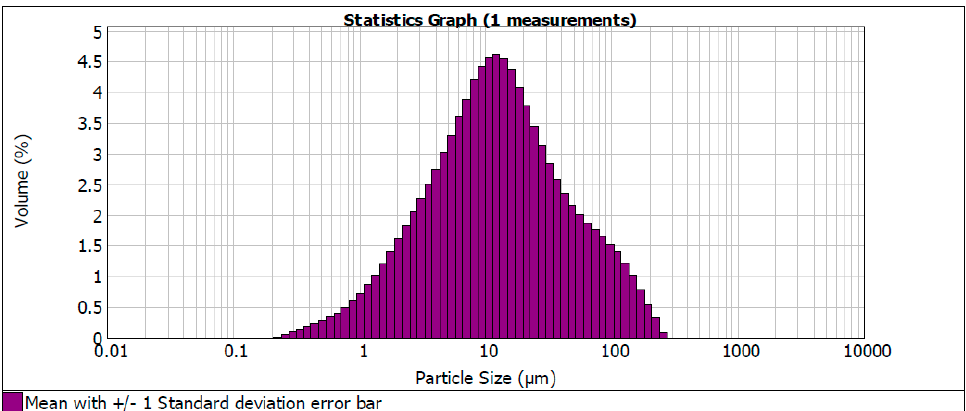
Figure 2. Particle size analysis of the powdered activated carbon sample.